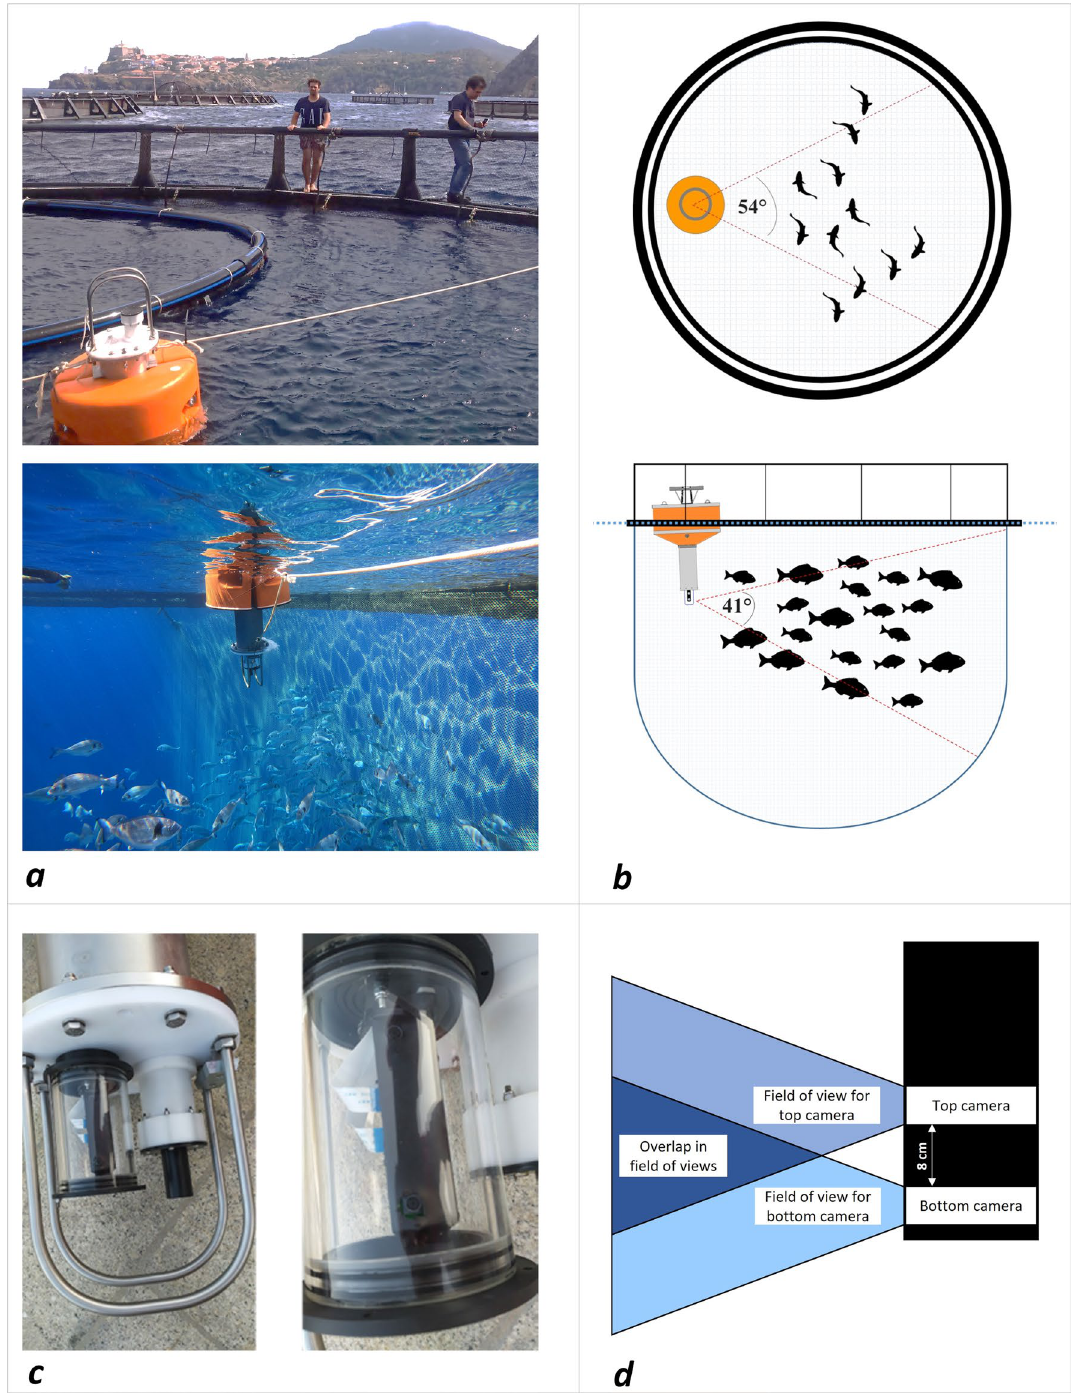
Figure 4. ( a , b ) Photos and images of buoy positioning inside the sea cage (Photos by N. Tonachella and M. Martinoli). ( c ) Close-ups of the stereo camera and plexiglass waterproof housing (Photo by F. Capoccioni), and ( d ) diagrams of the stereo camera’s fields of